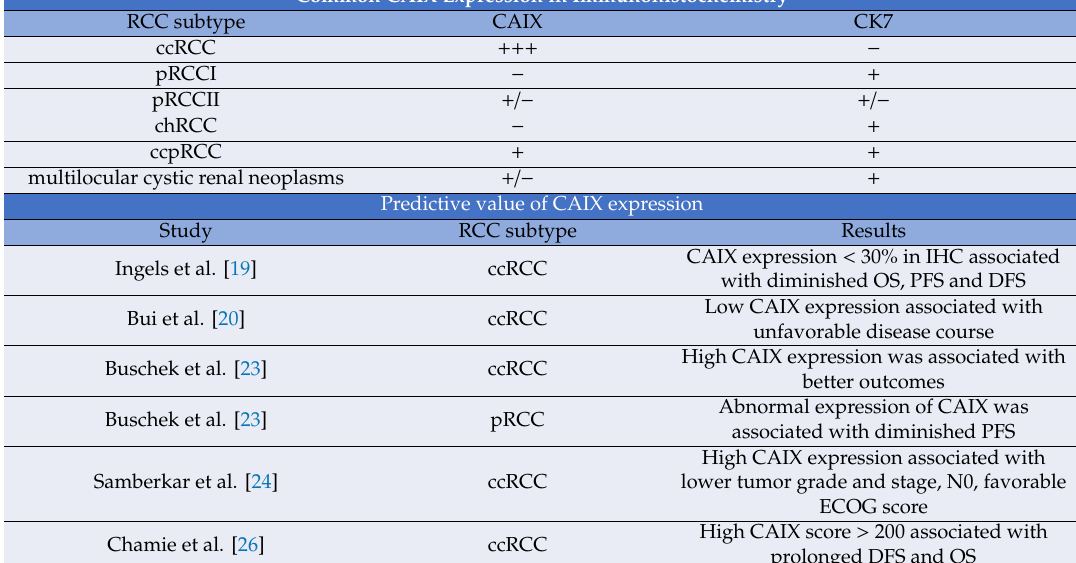
Table 1. Evidence synthesis of CAIX application for immunohistochemistry and its predictive value for clinical